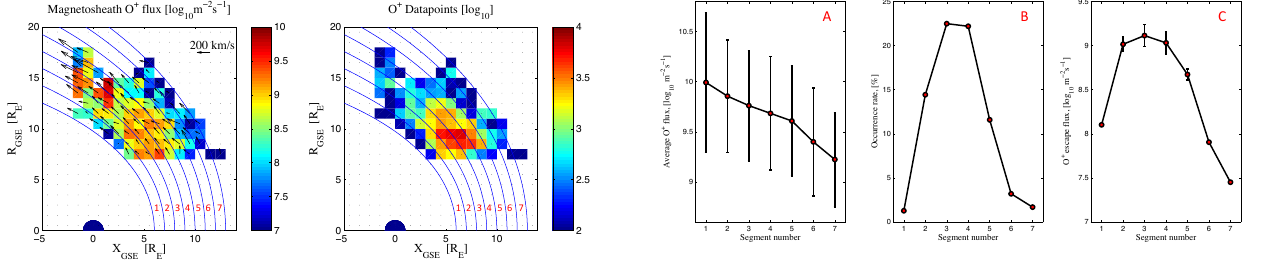
Fig. 1. Left: Average O + escape flux in the magnetosheath, given in cylindrical GSE coordinates. The flux Fig. 1. Left: average O + escape flux in the magnetosheath, given (m − 2 s − 1 ) is given by a color scale, and the bulk velocity (magnitude and direction) is given by black arrows. in cylindrical GSE coordinates. The flux (m − 2 s − 1 ) is given by a In the top right corner an arrow’s length defines the velocity corresponding to 200 km/s. The eight blue lines color scale, and the bulk velocity (magnitude and direction) is given dividesthemagnetosheathdatasetintosevensegments(numbered 1 − 7 )withawidthof ∼ 1 R E . Thelinesare by black arrows. In the top right corner an arrow’s length defines theoreticalmagnetopauses(Shue1998)cuttingtheX GSE − axisat 6 , 7 ,..., 13 R E . Right: Thespatialdistribution the velocity corresponding to 200km s − 1 . The eight blue lines di- oftheofthedatasetisshown. vide the magnetosheath data set into seven segments (numbered 1– were positioned in the magnetosheath, based on that the typical magnetosheath characteristics were 7) with a width of ∼ 1 R E . The lines are theoretical magnetopauses fulfilledintheobservedplasma. cutting the X GSE -axis at 6, 7, ..., 13 R E . Right: the spatial distri- The magnetosheath data set was then visually inspected for high energy O + ( > 3 keV). The rea- bution of the of the data set is shown. sonforalowerenergylimitistoavoidcontaminationoftheO + datawhenintenseprotonfluxesare 95 present. From inspection it is clear that significantly heated and accelerated O + ions reach particle energiesuptoatleast 38 keV(themaximumenergyperchargetobemeasuredbyCODIF),whereas themagnetosheathprotonsseldomreachenergiesabove 3 keV;seee.g. thecasestudypresentedby Slapak et al. (2012). Therefore, an O + set containing ions of energies > 3 keV is assumably unaf- fectedbytheintenseprotonfluxes,whereasalowenergysubset( < 3 keV)isstronglycontaminated. 100 Thisconditionisconfirmedwhencorrelatingtheprotonfluxeswiththefluxesofhighandlowenergy O + respectively. ThereisaclearcorrelationbetweentheH + fluxandthelowenergyO + fluxforthe magnetosheath data. A similar correlation cannot be seen when high energy O + flux is compared to the H + flux. Also, if the O + data is contaminated a peak at v ⊥ ( O + ) /v ⊥ ( H + )=1 / 4 would be expected (Nilsson et al. (2006)). This property is not seen; on the contrary v ⊥ ( O + ) is in general 105 similar to but somewhat larger than v ⊥ ( H + ) . These statistical characteristics of the magnetosheath